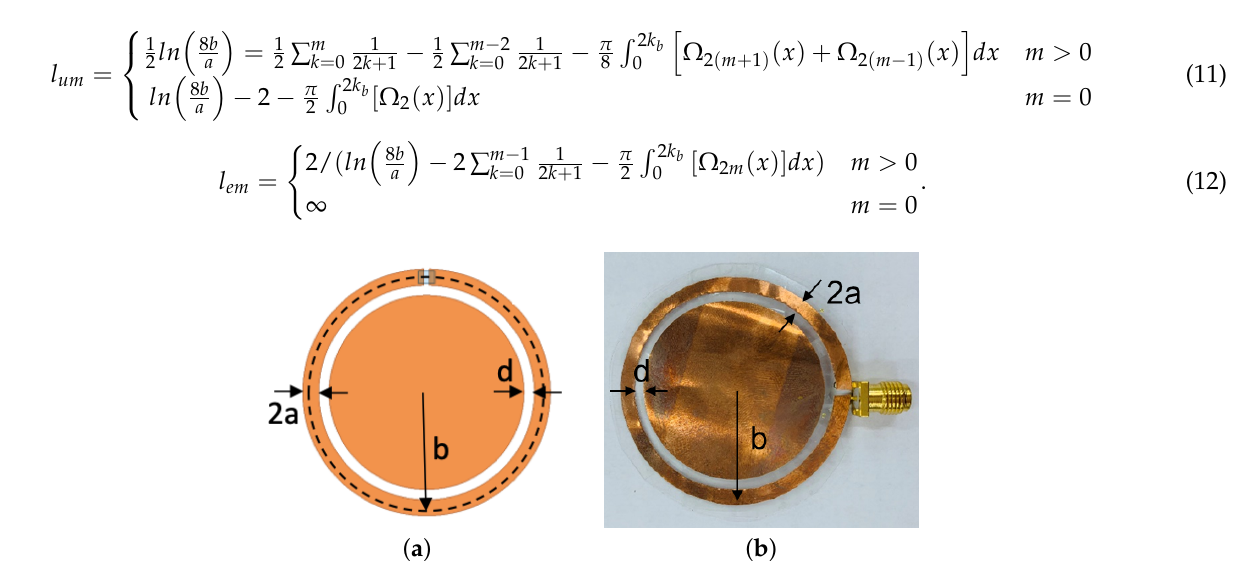
Figure 6. ( a ) Loop resonator with a center pad. b : Loop radius. 2 a : Loop width. d is the spacing distance between the metal pad and loop. ( b ) A photo of the tuned loop with U = 9, b = 20.9 mm, a = 1.44 mm, and d = 1.9